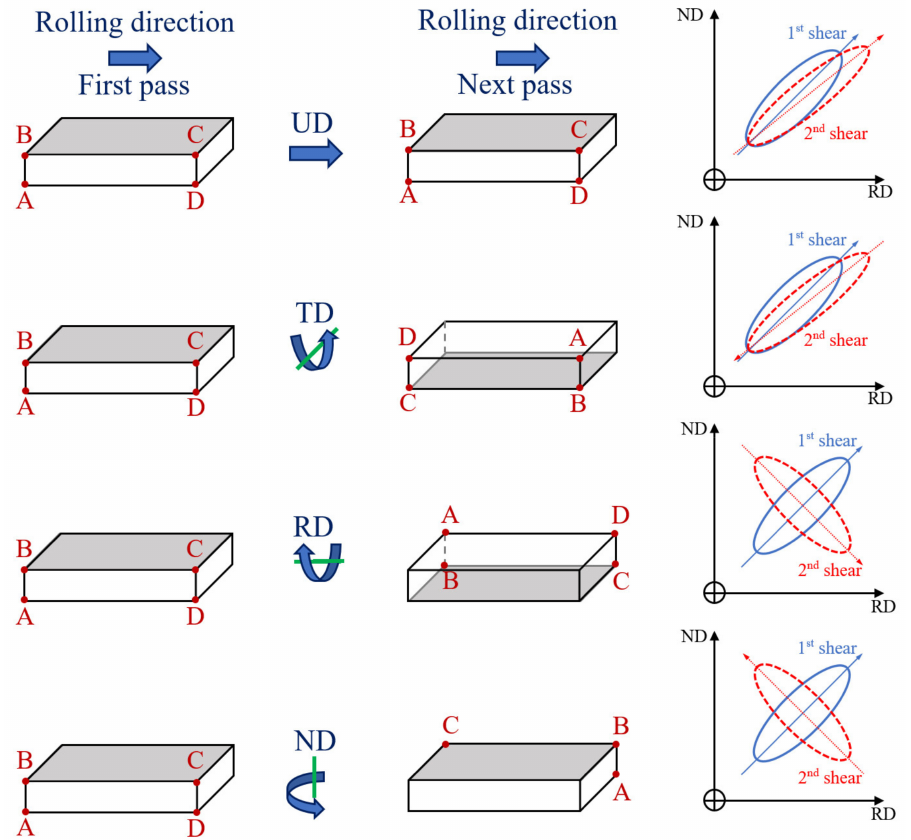
Figure 30. Schematic illustration of deformation routes and shear directions during asymmetric rolling. In UD rolling, rolling direction is not changed, whereas in TD, RD and ND rolling, the sheet is rotated through 180 ◦ about TD, RD and ND axes, respectively, for each pass. Reprinted from [84].